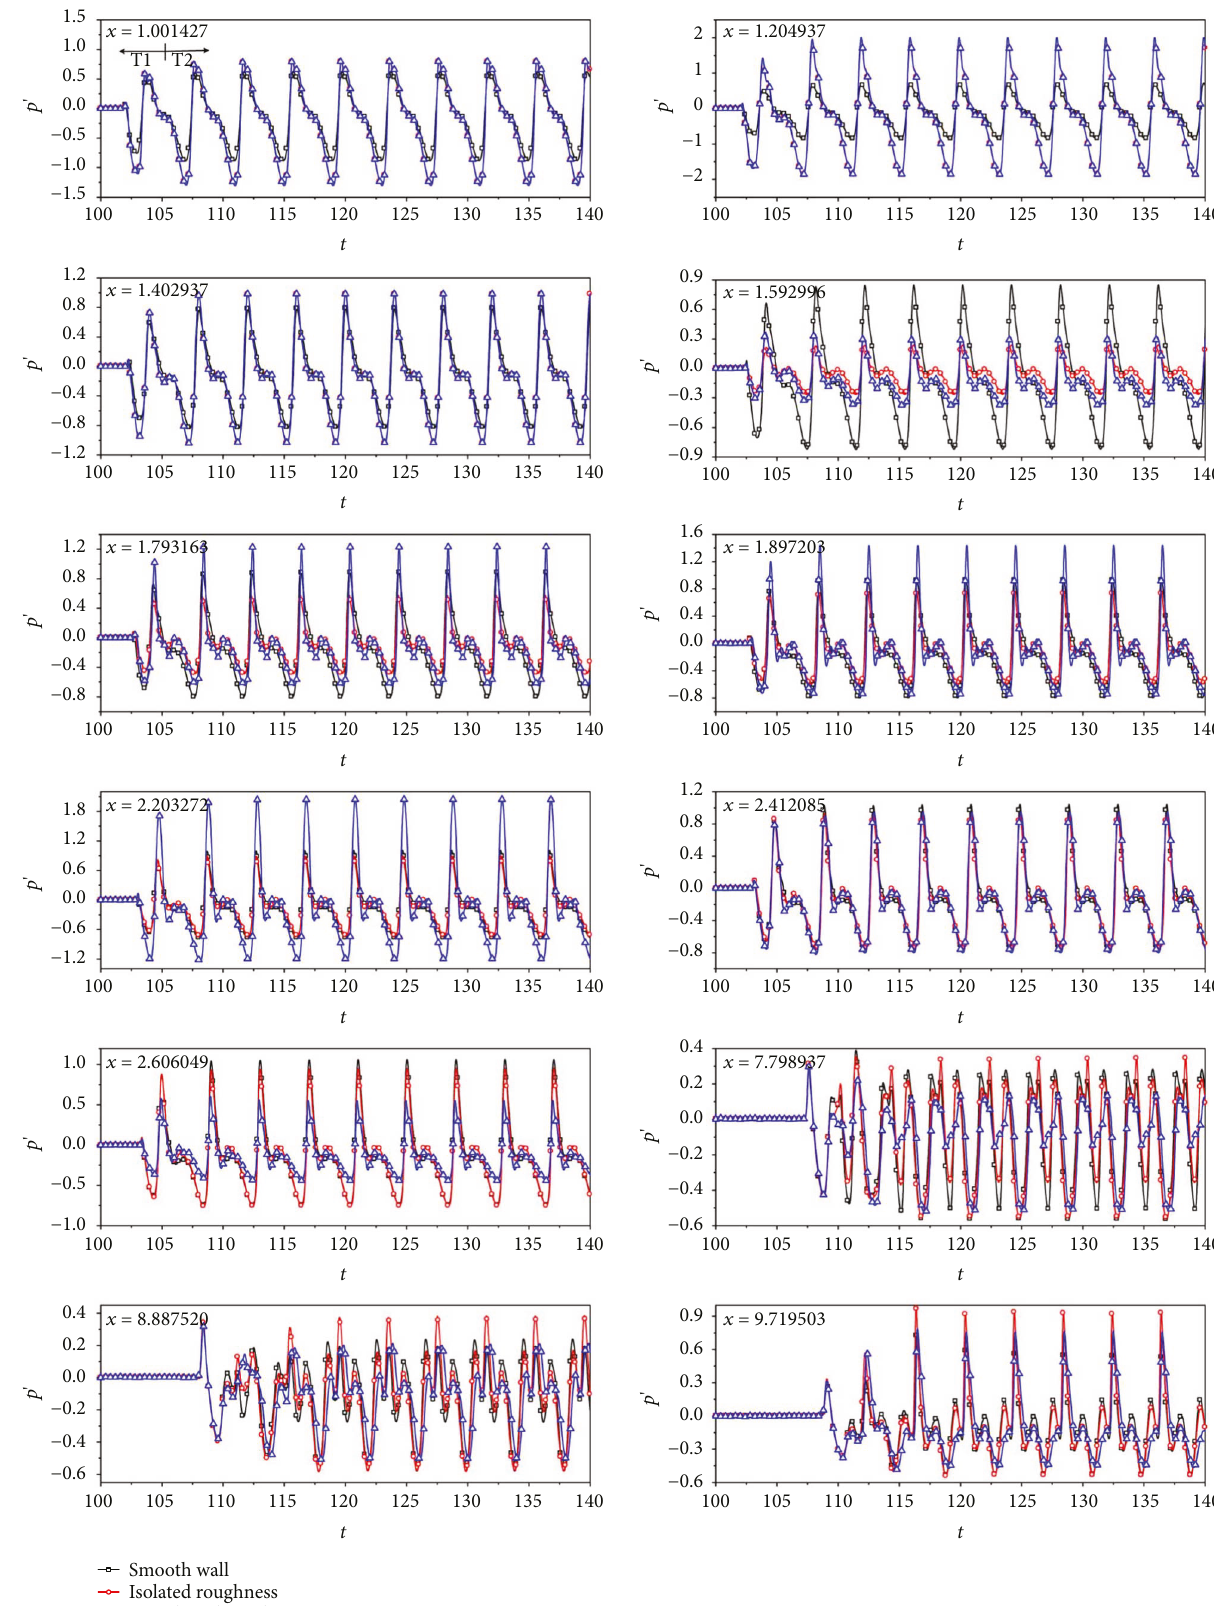
Figure 8: Pressure disturbance on the wall at di ff erent stations along the fl ow